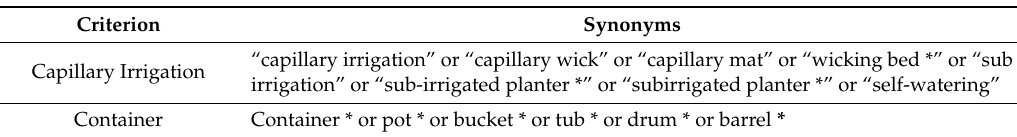
Table 1. Article screening criteria and